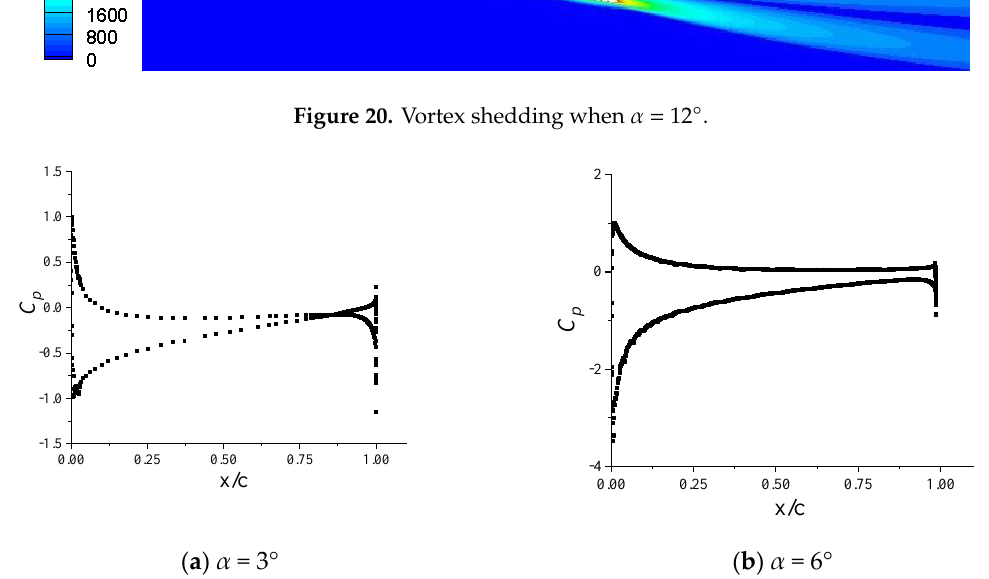
Figure 21. Pressure distribution on the surfaces of the hydrofoil.